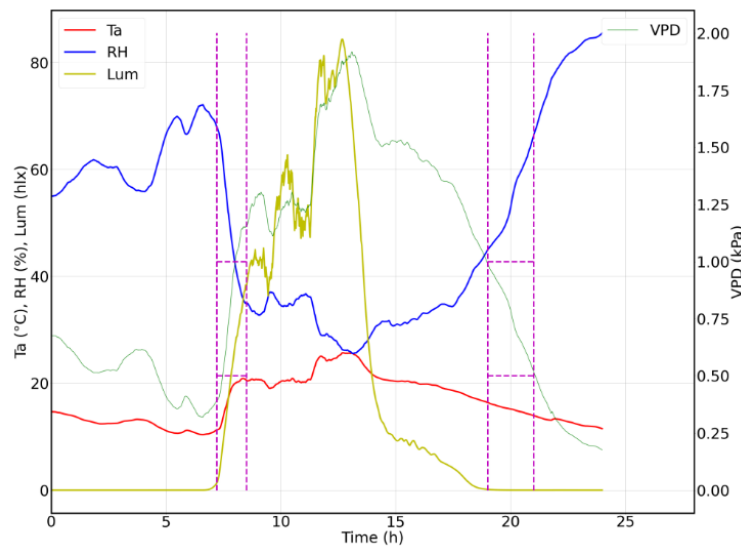
Figure 12. Favorable conditions for a low VPD.